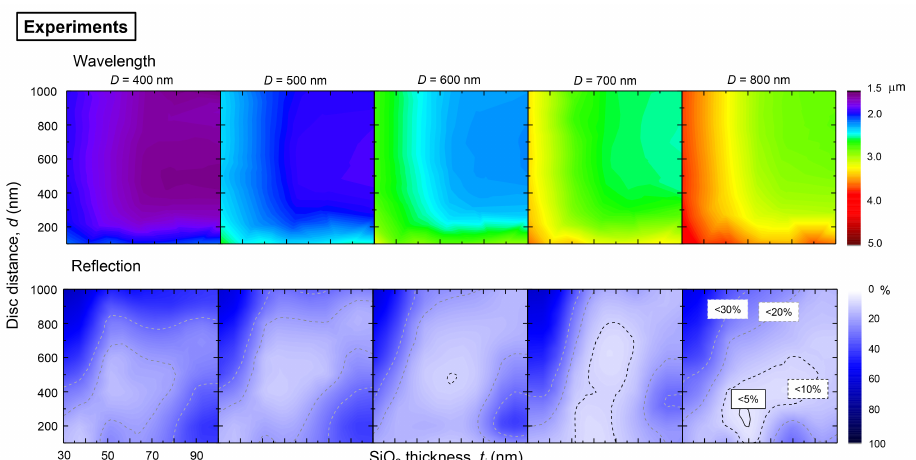
Figure 2. Experimental results of the resonance wavelength (color-coded) and minimum reflectance R obtained from series of reflection spectral measurements (400+) with parameters of disc diameter D , intra-disc separation distance d and SiO 2 thickness t i . Number of samples measured for one D was ( 10 × 8 ) = 80 for different t × d . i